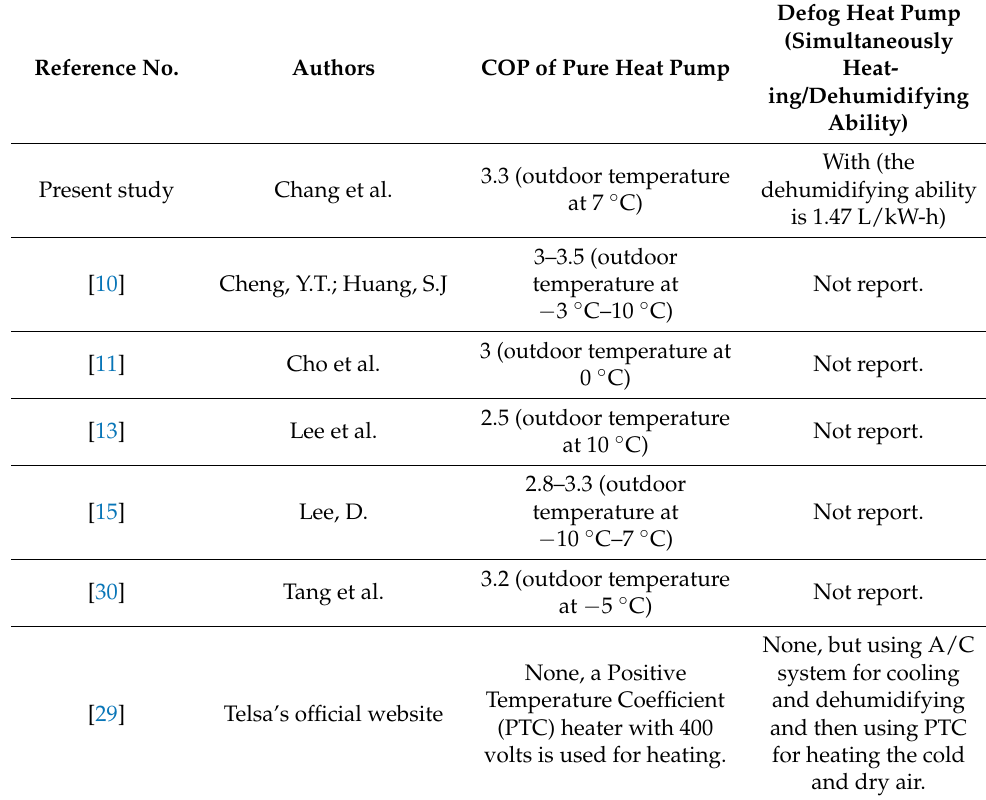
Table 3. Comparison of HVAC systems with the other studies.